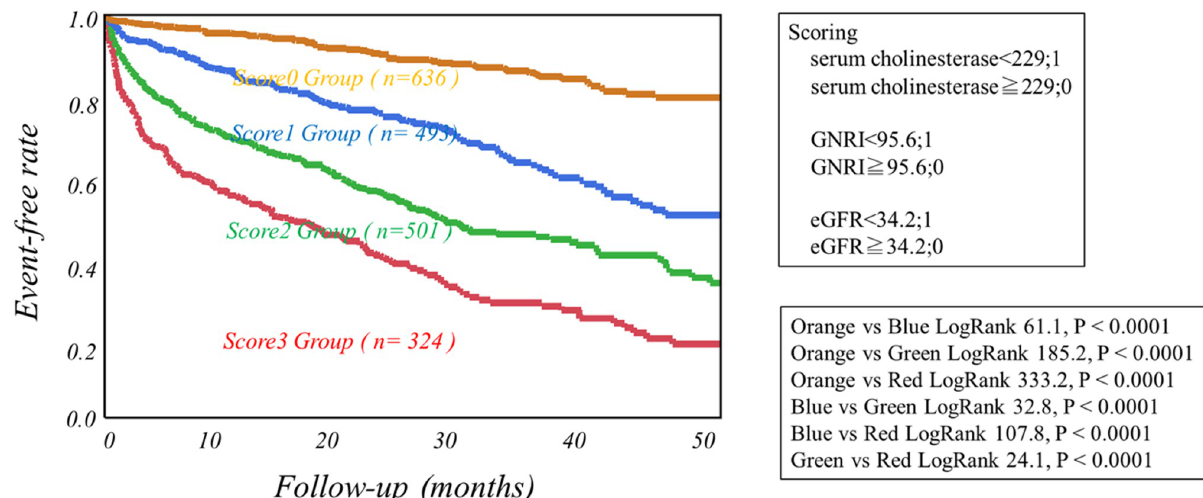
Fig 3. Kaplan-Meier event-free curves based on the accumulated number of the three prognostic variables including serum cholinesterase, Geriatric Nutritional Risk Index (GNRI) and estimated GFR.